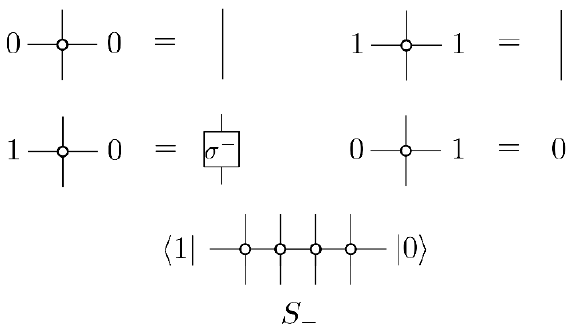
Figure 15 . An MPO description of the lowering operator. The MPO S (cid:0) = O ( O; X; n ) is de(cid:12)ned with O as given in the (cid:12)gure and with X = (cid:27) (cid:0) .